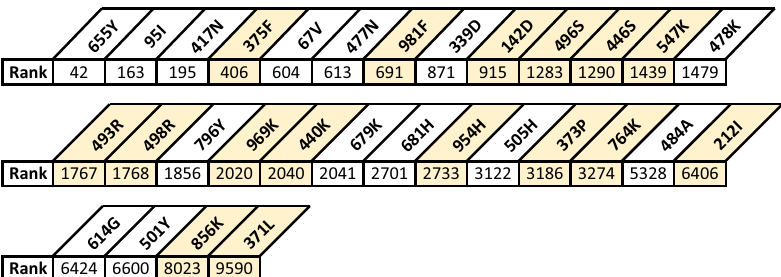
Fig. 5 Rank of spike protein amino acid substitutions. Ranking was performed by our prediction model on 13,544 possible non-synonymous amino acid substitutions in the spike protein resulting from one nucleotide change. The ranks of the 30 substitutions comprising the Omicron variant (lineage B.1.1.529) are shown. The highlighted substitutions were not part of the